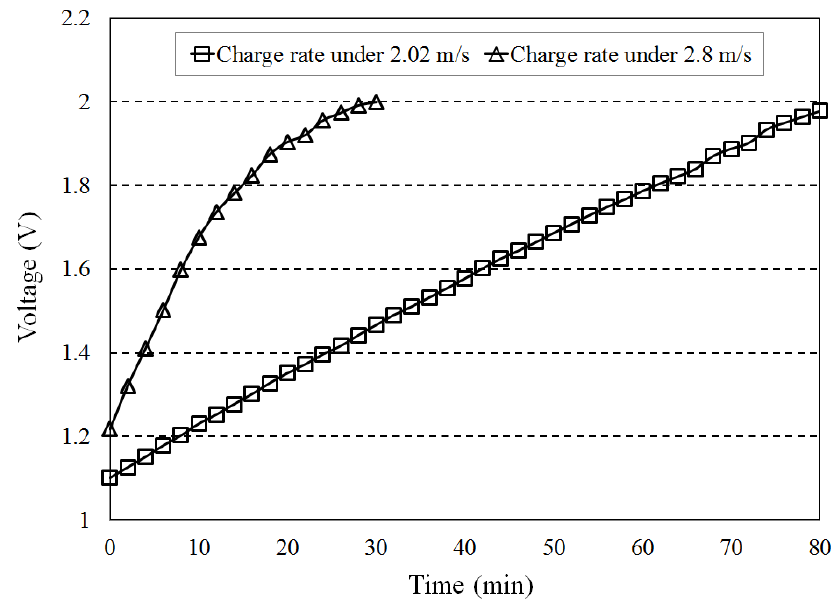
Figure 13. Comparison of charging rates at different wind speeds for the 1 F super